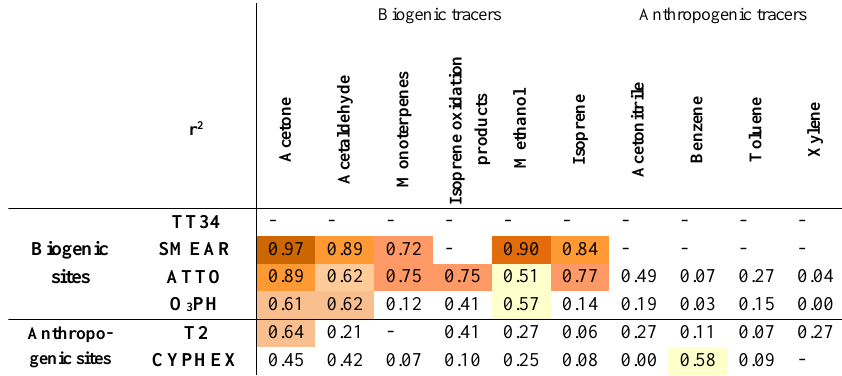
Table 3. Correlation coefficients ( r 2 ) of MEK with other co-measured VOC at the sites investigated. The correlations above 0.5 are colour- Table 3: Correlation coefficients (r 2 ) of MEK with other co-measured VOC at the sites investigated. The coded with warmest colours for highest correlation coefficients. Correlation coefficients ( r 2 ) for the TT34 site in Amazonia are missing due correlations above 0.5 are colour coded with warmest colours for highest correlation coefficients. Correla- to lack of data. tion coefficients (r 2 ) for the TT34 site in Amazonia are missing due to lack of data.